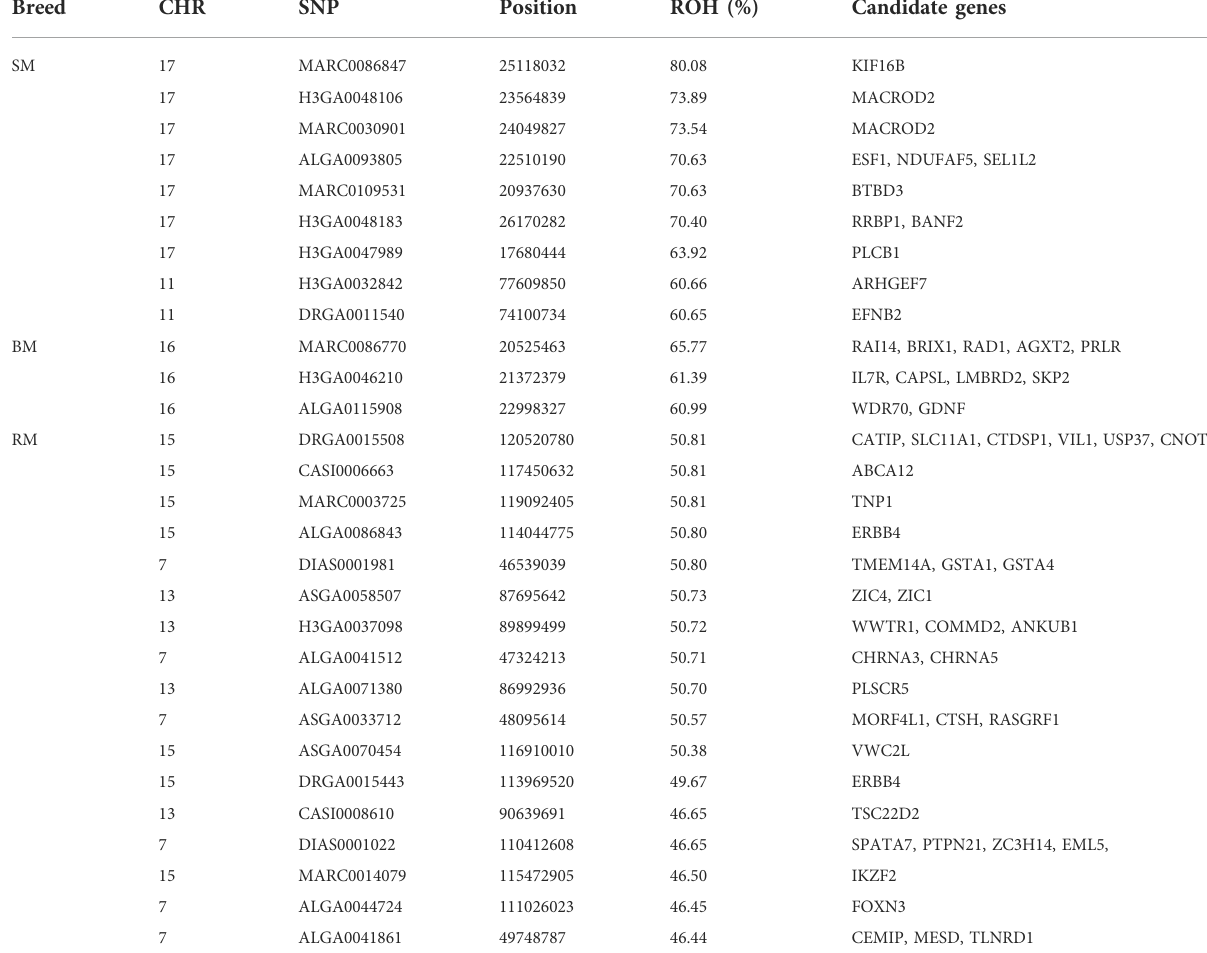
TABLE 3 Summary information of signi fi cant SNPs and candidate genes from ROH islands in three Mangalitsa pig breeds (BM, SM and RM).